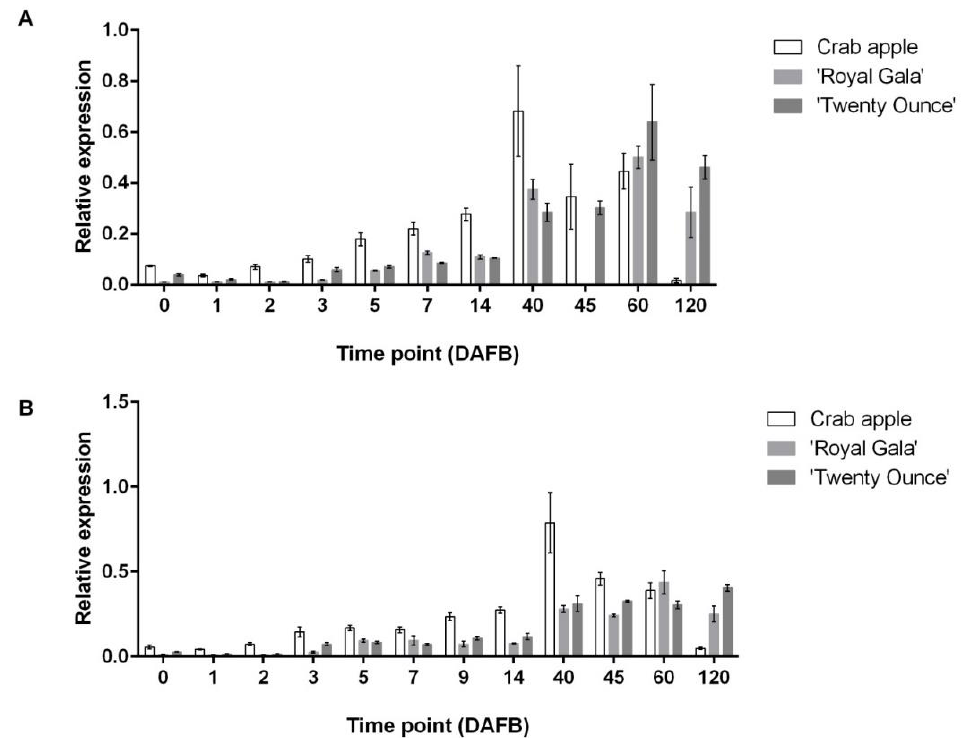
Figure 8. Differential expression of MdEXP3 in three cultivars during Season 2, relative to the control gene, MdGAPDH . ( A ) Relative expression in biological Replicate 1 (Rep1). ( B ) Relative expression in biological Replicate 2 (Rep2). Error bars = standard deviation; n = 3 (technical replicates). Expression between time points and cultivars were statistically different, ANOVA (two-factor), p -value ≤ 0.05.